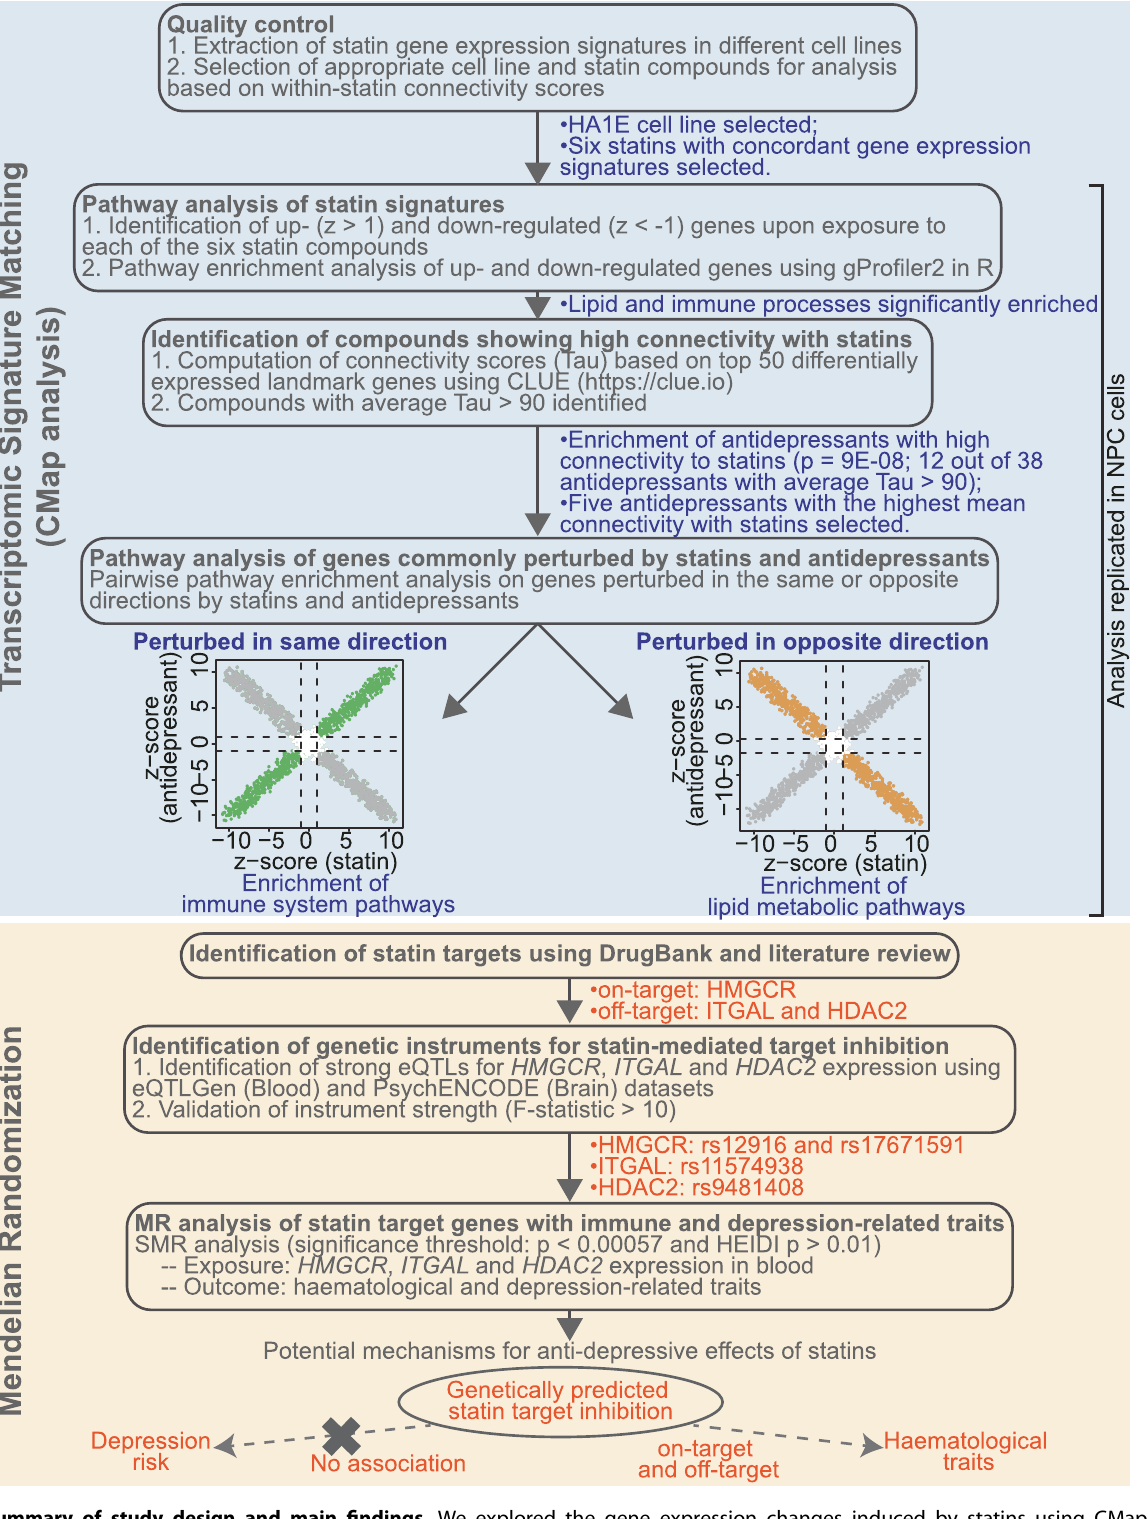
Fig. 4 Summary of study design and main fi ndings. We explored the gene expression changes induced by statins using CMap gene expression signatures, and identi fi ed biological processes perturbed by statins and antidepressants in the same or opposite direction. We performed Mendelian randomization (MR) analysis to investigate the association of genetically predicted statin target inhibition with various haematological and depression-related